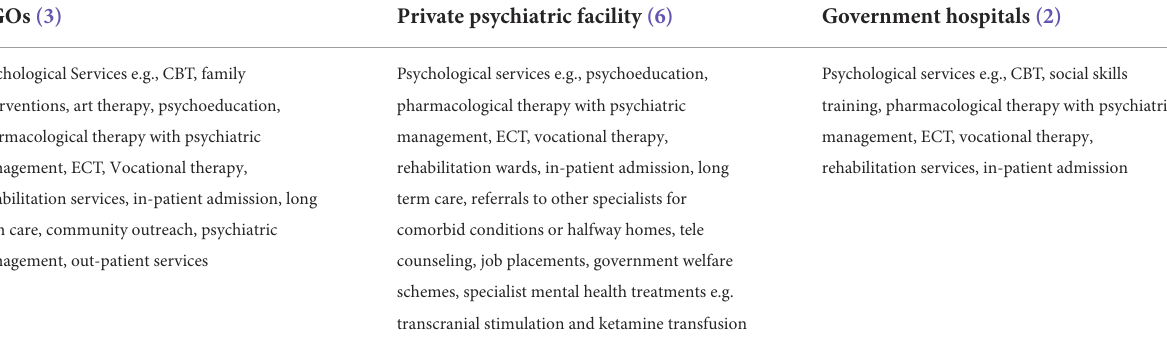
TABLE 4 Summary of types of services offered to people with severe mental illnesses by type of mental health facility in the study sample. NGOs